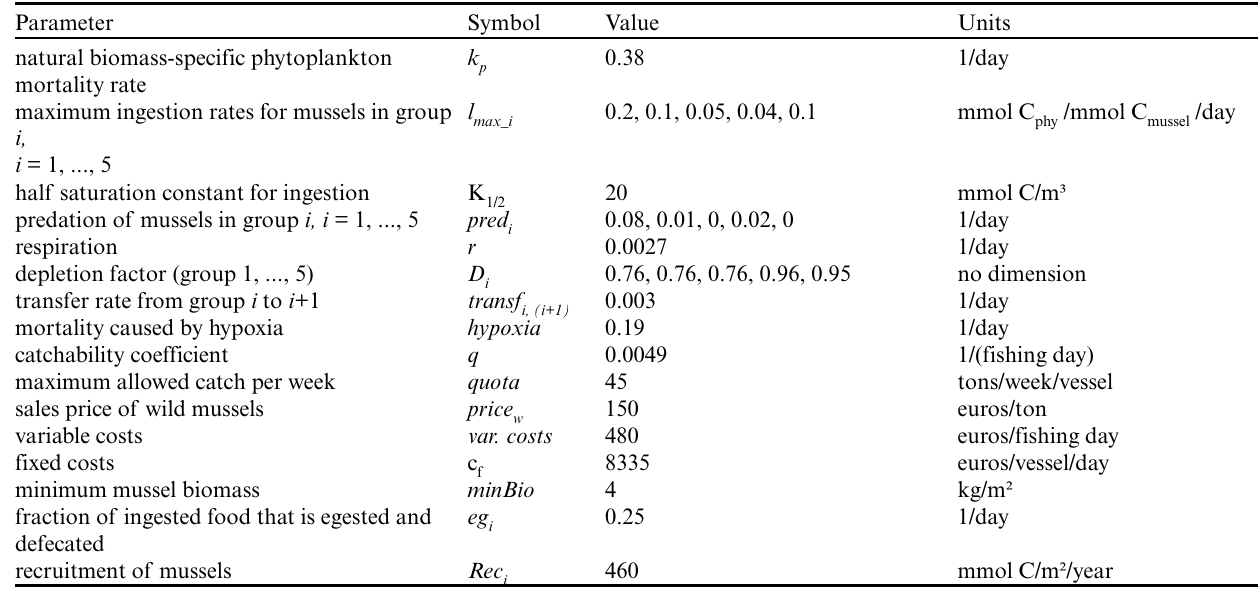
Table 1 . Parameter values used in the bioeconomic model